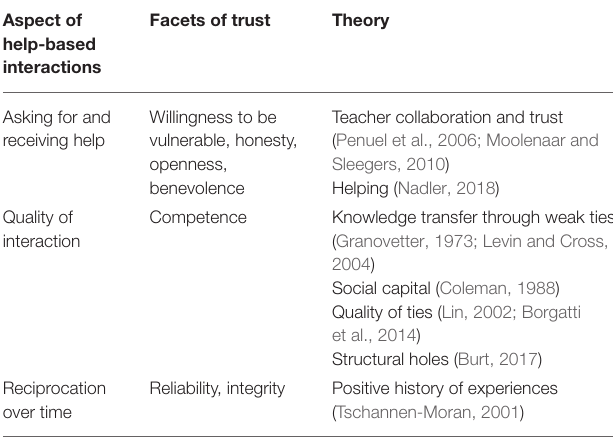
TABLE 1 | Theoretical connection between help-based interactions, the facet of trust they align with, and related research. Aspect of